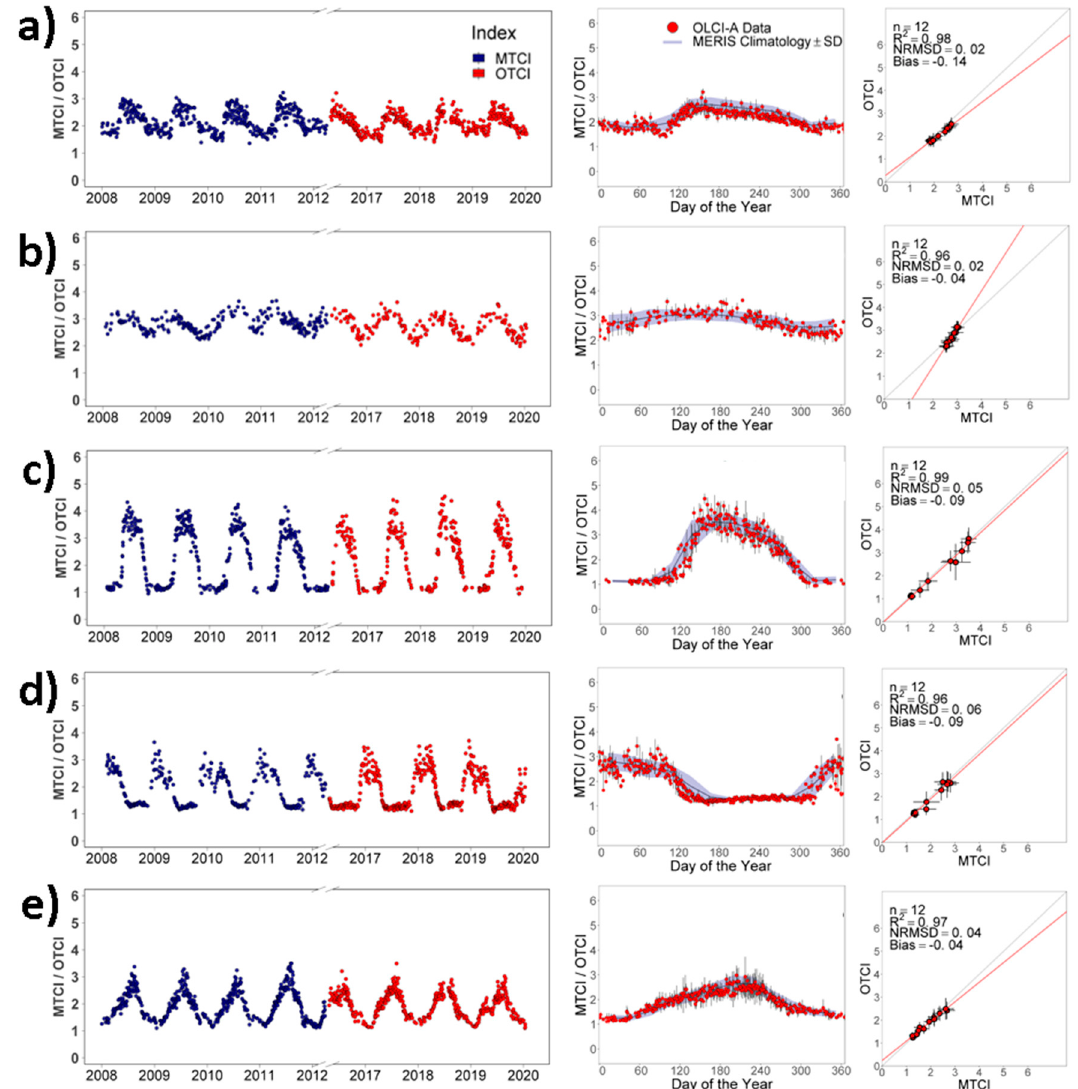
Figure 3. Temporal profiles of MTCI (2008 to 2012) and OTCI (2016 to 2019) acquisitions (left), Sentinel-3 OTCI acquisitions and monthly mean Envisat MTCI values derived from the MERIS climatology by day of year (middle) and scatterplot of monthly means (right) for ( a ) US-Talledaga (ENF), ( b ) AU-Robson-Creek (EBF), ( c ) FR-Montiers (DBF), ( d ) BR-Mataseca (non-forest), and ( e ) IT-Lison (cultivated). Table 4. Statistics of the comparison between monthly mean Sentinel-3 OTCI (2016 to 2019) and Envisat MTCI (2002 to 2012) values over the considered validation sites. Sites are sorted by the NRMSD.